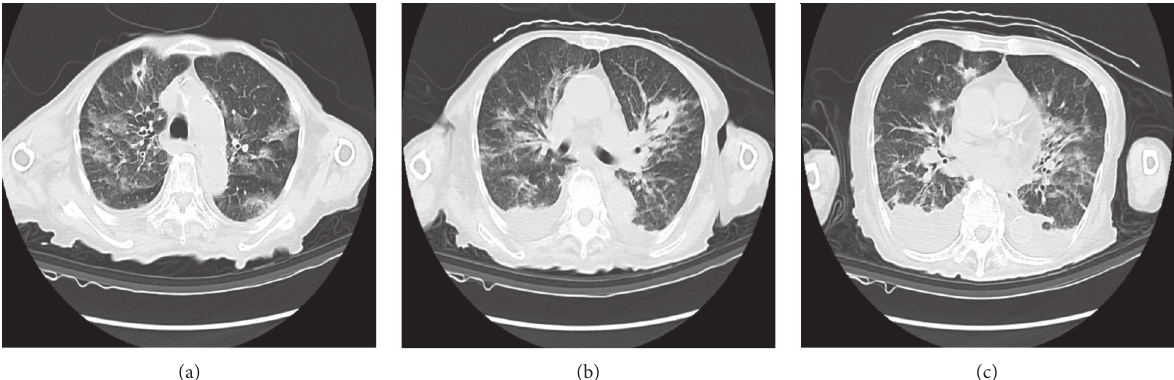
Figure 2: Chest CT image at the upper lobe level (a), at the carina level (b), and at the lower lobe level (c) on admission. Chest CTshowed grand glass opacity in all fields with consolidation in the right and left lungs.